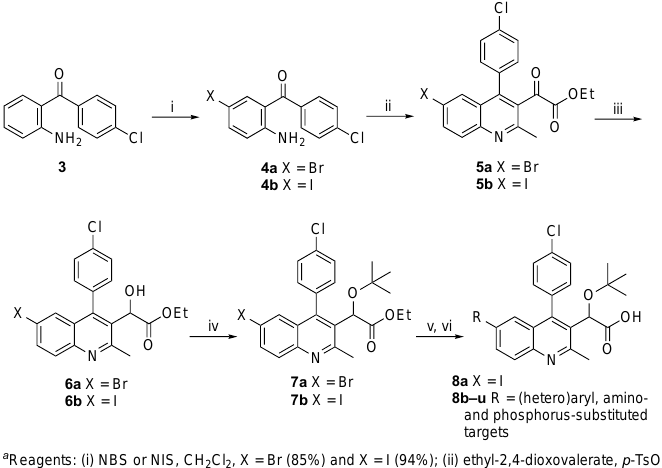
Viruses 2022 , 14 , 1466